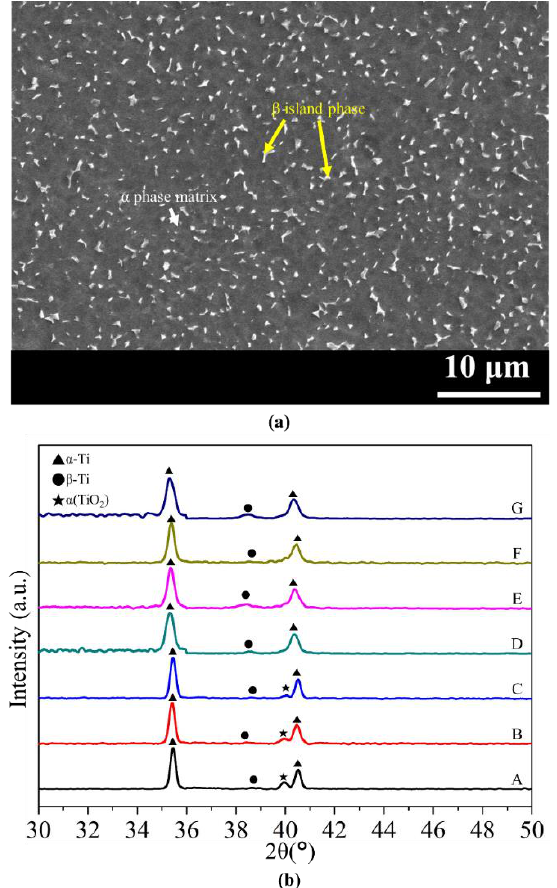
Figure 7. ( a ) A typical SEM micrograph of control specimen G , revealing that an equiaxed α